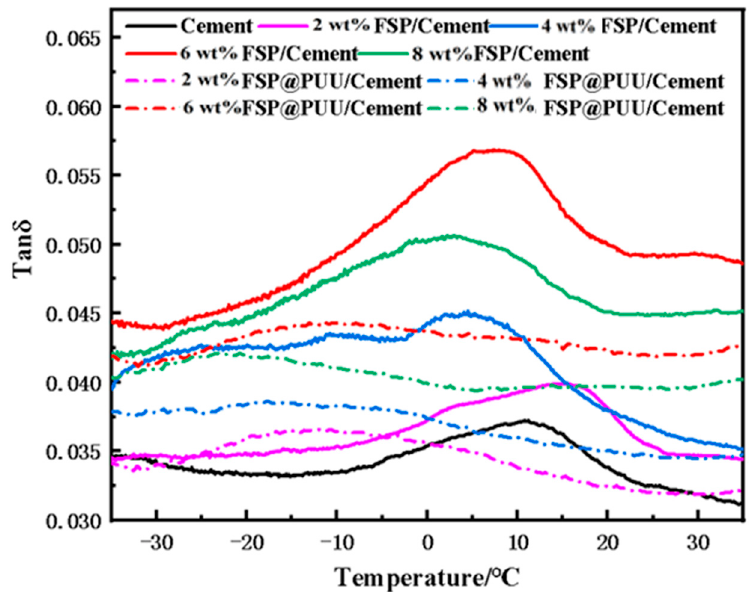
Figure 9. Loss tangent changes of 4 × 12 × 60 mm prismatic specimens for different FSP and FSP@PUU additions at different